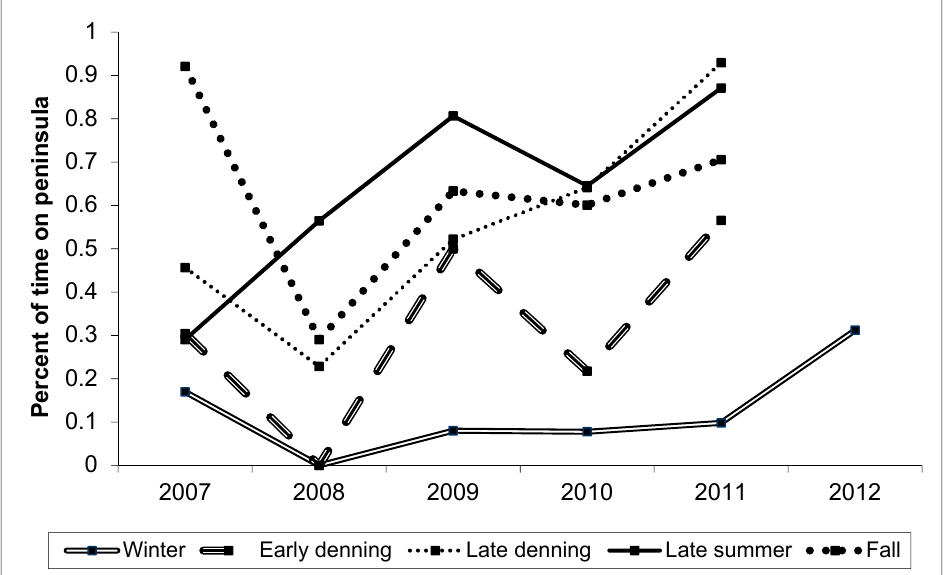
Figure 2. Proportion of time by season from 2007 – 2012 that Ualik Lake Pack wolves occurred on the Nushagak Peninsula, Togiak National Wildlife Refuge, southwestern Alaska.